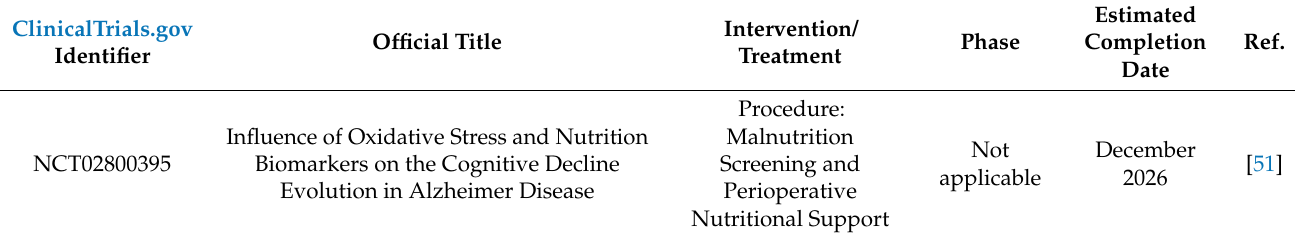
Table 3. Summary of active clinical trials investigating Alzheimer’s disease in relation to oxidative stress. The studies have been retrieved from clinicaltrials.gov with search keywords “Condition or disease = Alzheimer disease” and “Other terms = oxidative stress” and selecting the items with the status “Recruiting” and “Active, not